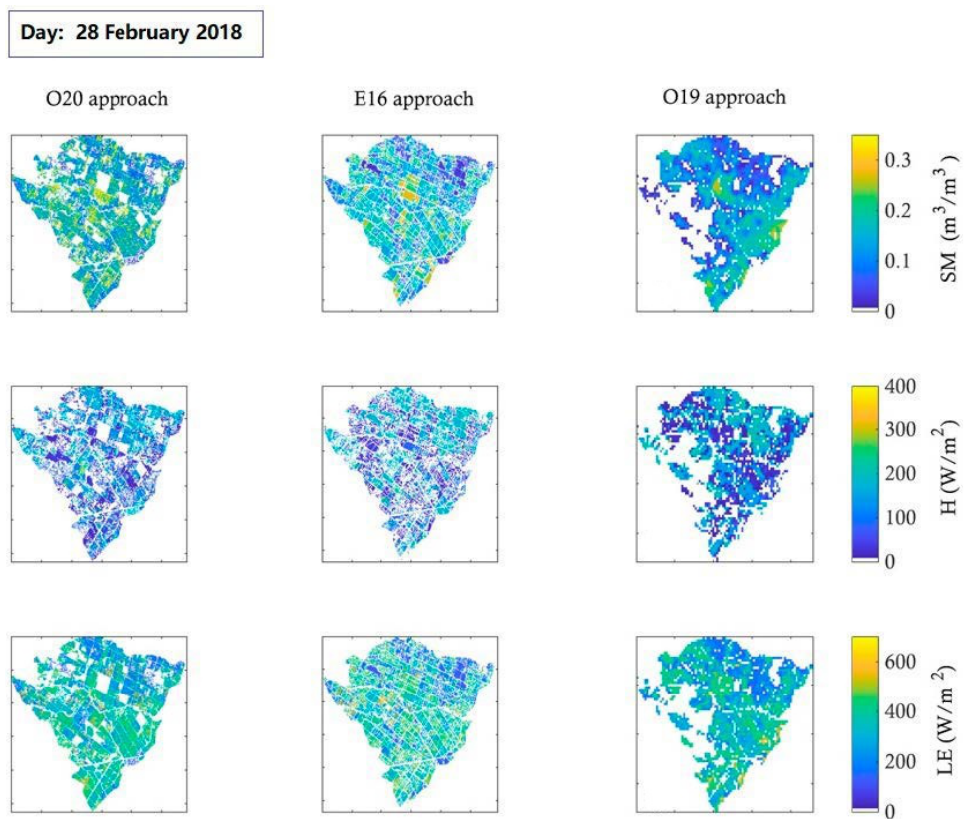
Figure 10. Same as Figure 9, but for 28 February 2018.